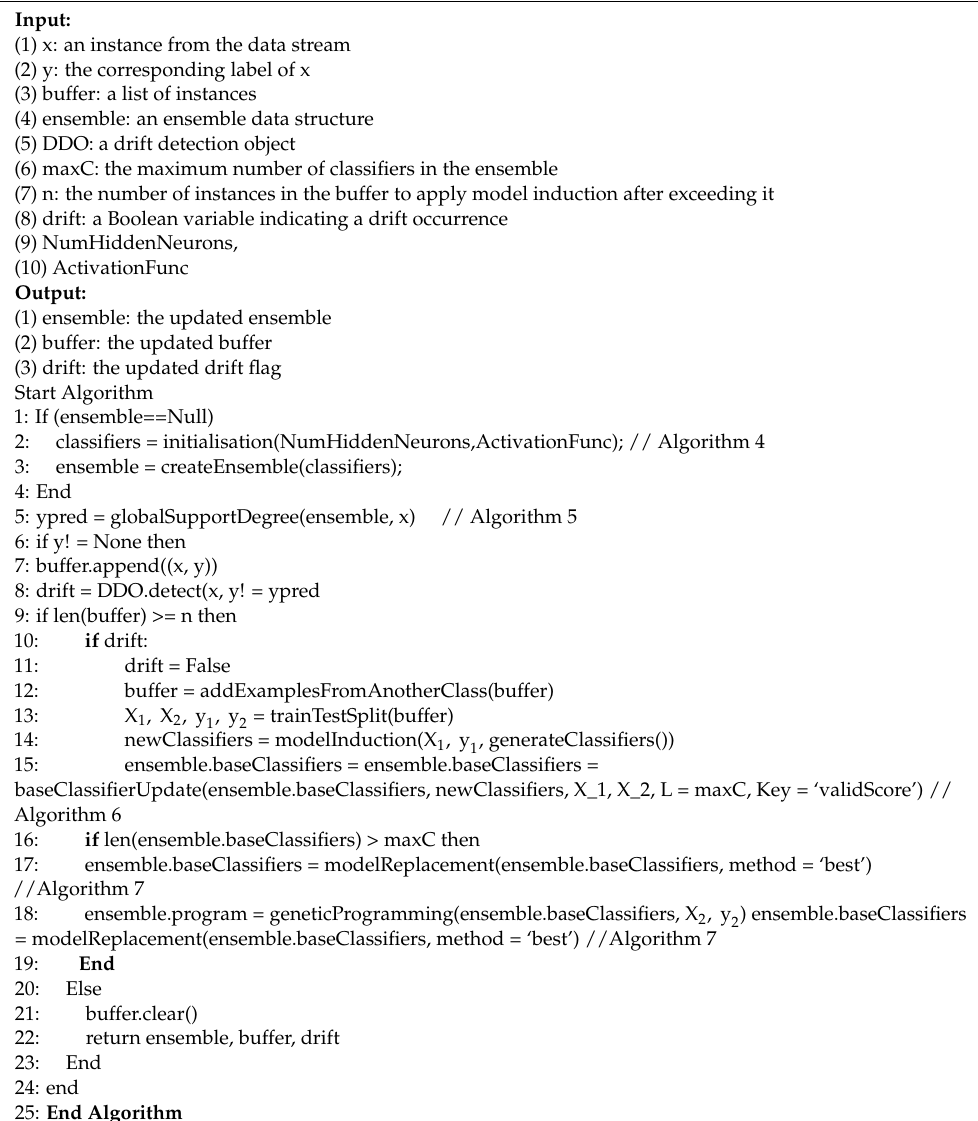
Algorithm 3. Pseudocode of